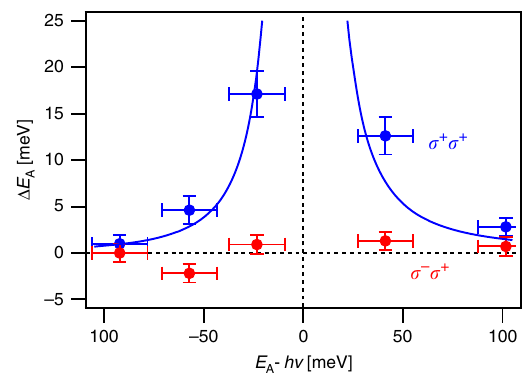
Fig. 6 Optical Stark effect near A-exciton resonance in monolayer WS 2 . The maximum photo-induced shift of the A-exciton energy recorded for co- (blue) and cross-circularly polarized (red) pulses as a function of pump photon energy detuning. The pump power was kept constant throughout. The error bars in detuning represent the sum of the estimated bandwidth of a 150 fs Gaussian pulse (~12 meV) and uncertainties in the center wavelengths of both the pump pulse and the unperturbed A-exciton absorption. The error bars in Δ E represent the sum of uncertainties in center wavelength of the unperturbed A-exciton absorption and of the absorption at time zero. The solid blue line is a fi t to Eq. (6) for 150fs 10 µ J/cm 2 pulses, E b = 320meV, and M gx = 6.1± 0.7